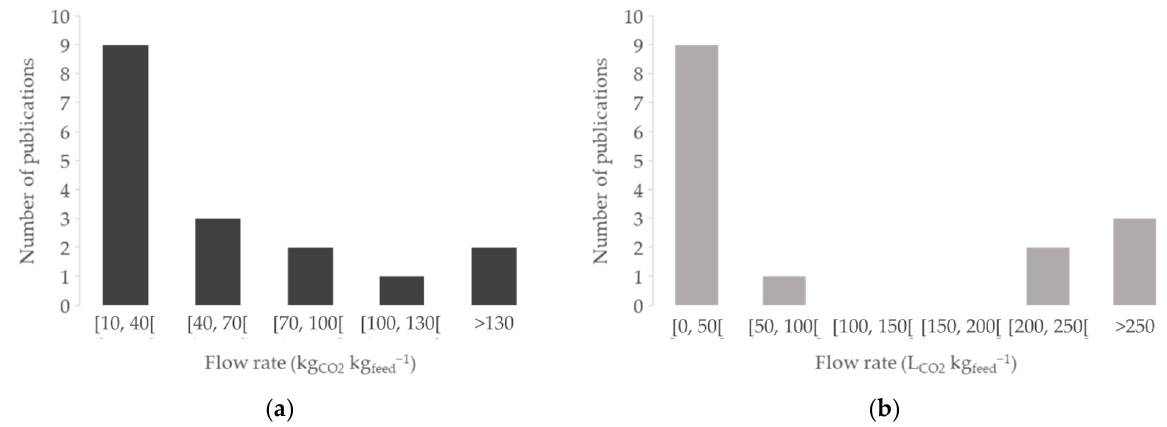
Figure 7. Typical mass ( a ) and volumetric ( b ) flow rates used in research on tomato SFE. Rozzi et al. [64] tested the effect of solvent flow rate on the SFE of lycopene from tomato seeds and skins. At 344.7 bar and 86 ◦ C, CO 2 flow rates ranging from 2.5 to 15 mL min − 1 decreased the lycopene yield from 4.59 to less than 1.0 µ g g raw material − 1 . The lower yield may be explained by the channeling and uneven distribution of the CO 2 at the highest flow rates.